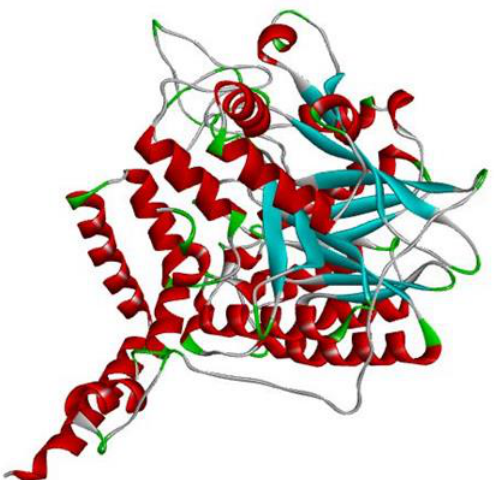
Figure 2. Discovery studio visualizer representation of the PDB structure of human acid sphingomyelinase, i.e., ASM with zinc; EC number-3.1.4.12; PDB ID-5I81. Red represents helices, blue indicates beta sheets and grey corresponds to loop regions.